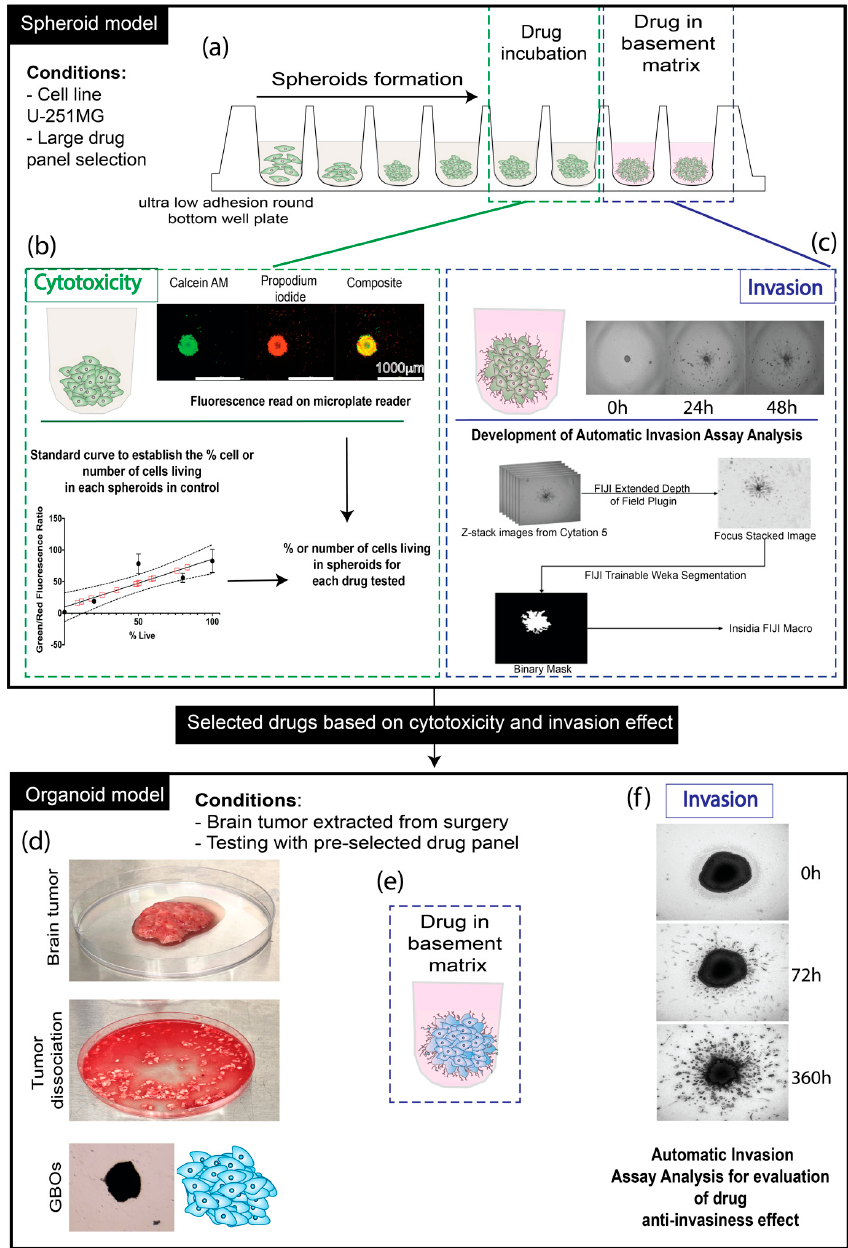
Figure 1. Schematic of experimentation. ( a ) U-251 MG cell spheroid formation in an ultra-low attachment round bottom well plate, followed by either drug incubation for cytotoxicity analysis or drug (10 µ M) distributed in the basement membrane matrix Matrigel for invasion assay analysis. ( b ) Cytotoxicity assessment of the compounds on spheroids by interpolation of the standard curve established based on Calcein AM (green: living cells) and propidium iodide (red: dead cells) fluo- rescence intensity related to the known ratio of living/dead cells (0, 20, 50, 80, and 100%), with the establishment of a standard curve allowing us to interpolate (following mathematical model with Graphpad: Prism) (Figure S2) the percentage of living cells and also the number of cells related to the fluorescence intensity. ( c ) Development of an automatic invasion assay analysis using FIJI/ImageJ and INSIDIA macro. ( d ) Brain tumor extracted from surgery, followed by dissection and dissociation to constitute the GBOs. ( e ) Transfer of the GBOs in an ultra-low adhesion well plate with the drug incorporated in the basement matrix. ( f ) Evaluation of the invasiveness of the GBOs for 360 h maximum, using automatic invasion assay